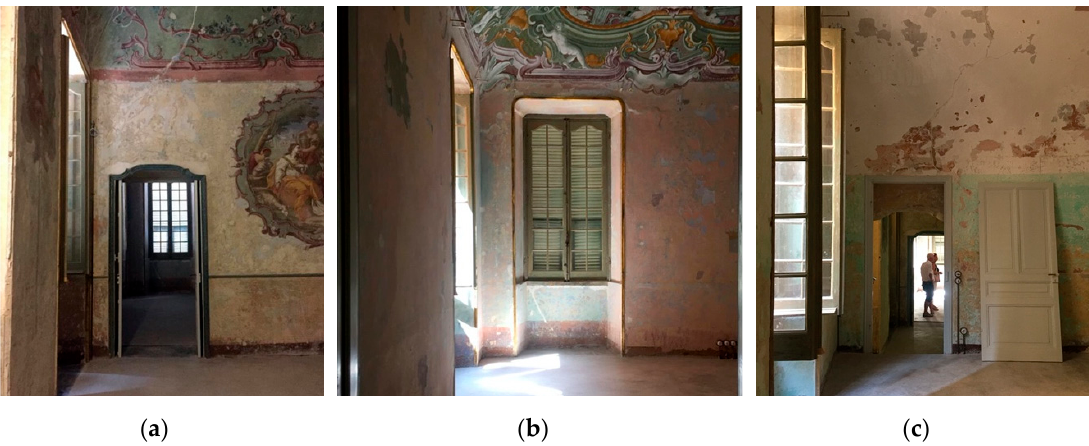
Figure 16. ( a ) Restoration of the walls of the second room, ( b ) restoration of the walls of the first room and ( c ) restoration of the walls of the room with the